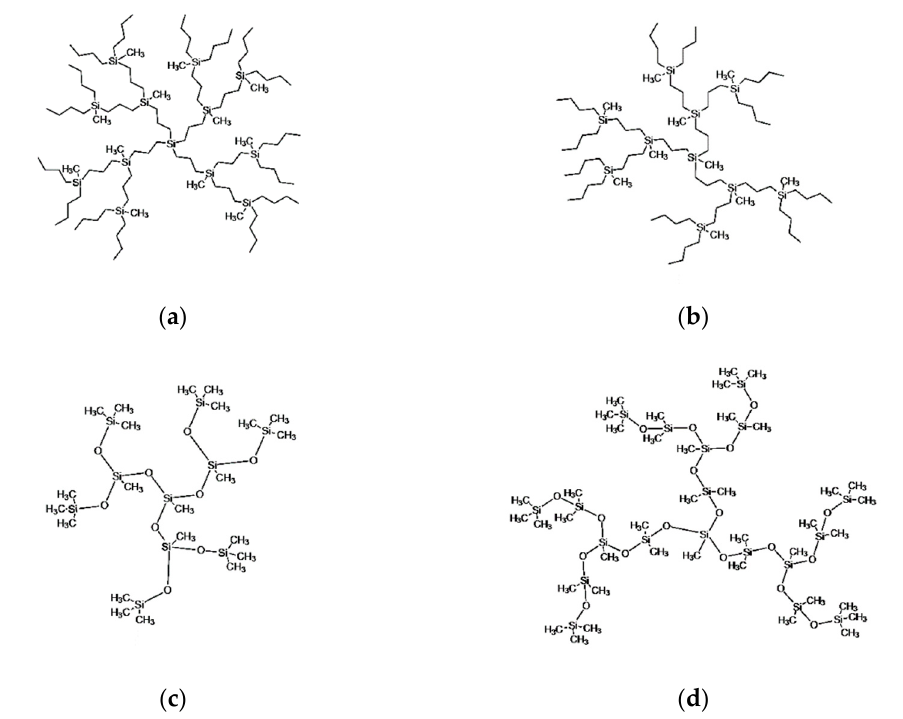
Figure 1. Schematic representation of the second-generation dendrimers belonging to the four homologous series under Scheme C4 dendrimers ( a ), C3 dendrimers ( b ), siloxane S-dendrimers ( c ), and L -dendrimers ( d ).